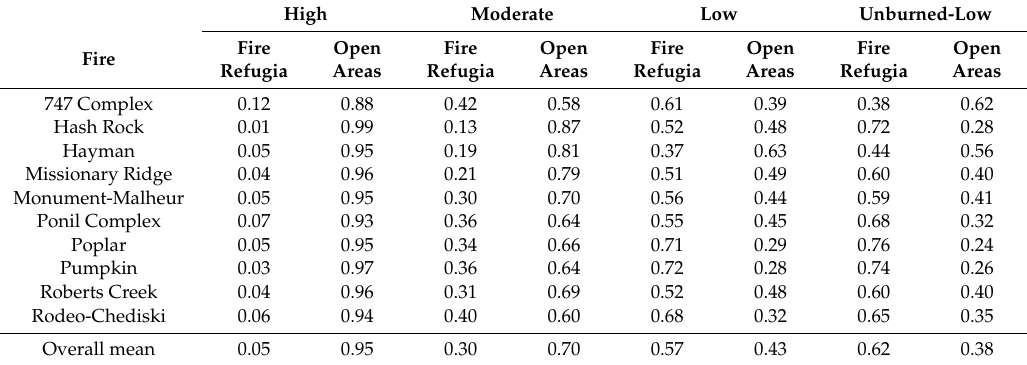
Table 4. Proportion of each MTBS dNBR burn severity class composed of fire refugia and open areas.